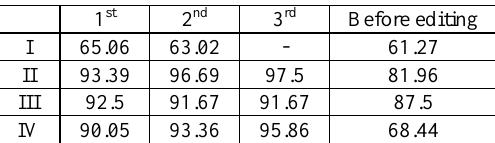
Table 4. Overall accuracies for classification trained with training data that are edited with k-means